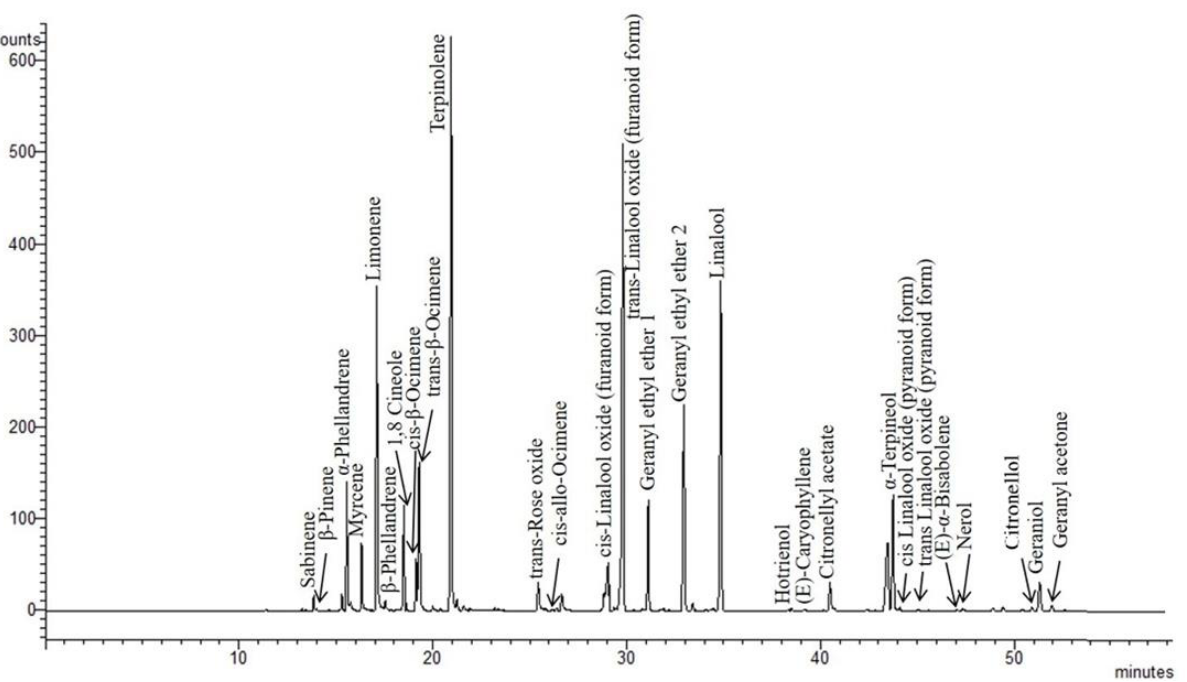
Figure 1. HS-SPME-GC-MS (head space-solid phase micro extraction-gas chromatography-mass spectrometry) profile in SIM (selected ion monitoring) mode (m/z = 93.0 + 121.0 + 136.0) of a fortified Moscato Giallo wine sample.